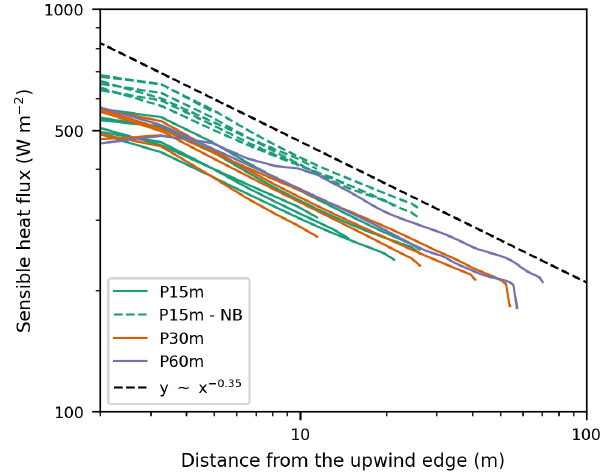
Figure 7. Time-averaged surface sensible heat fluxes over single patches of snow. The surface sensible heat fluxes for individual patches with snow as a function of distance from the leading edge on a log-log scale at y = 1 . 1m are shown. The dashed black line is a trendline implemented to show the approximate power law decay of the fluxes over distance. The fluxes of the snow are multiplied with − 1 so that these values can also be plotted on logarithmic